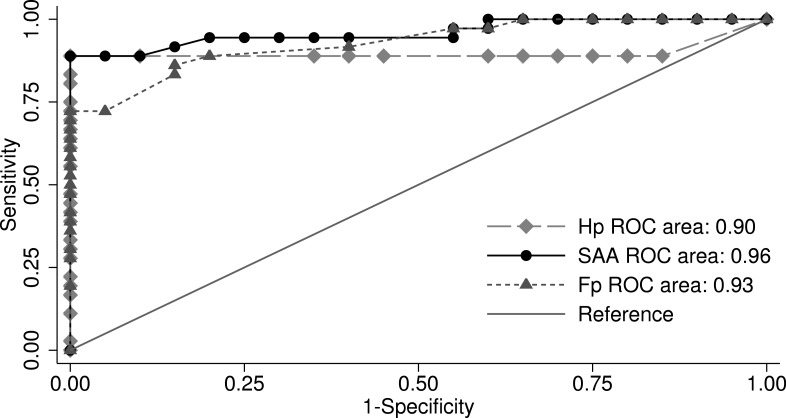
 Receiver operating characteristic plot: comparison of the area under the curve (AUC) for haptoglobin (Hp), serum amyloid A (SAA), and fibrinogen (Fb).